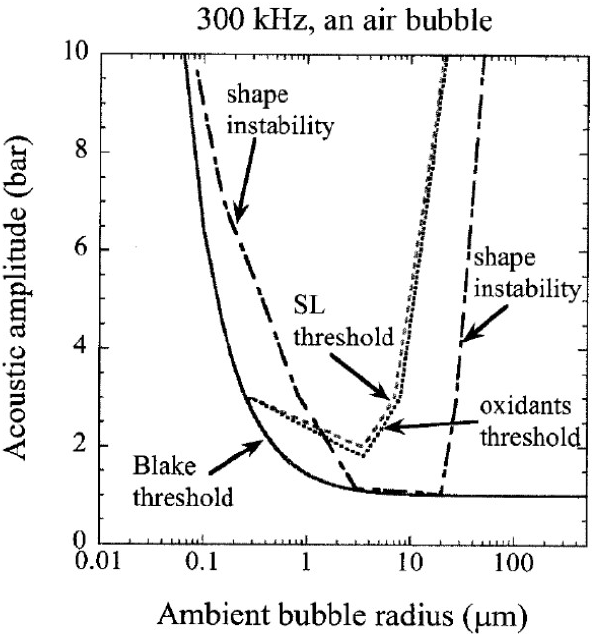
Figure 15. The calculated thresholds for the shape instability, for SL, and for oxidant production as well as the Blake threshold in R 0 -p a plane [43]. Copyright 2008, with the permission of AIP Publishing.